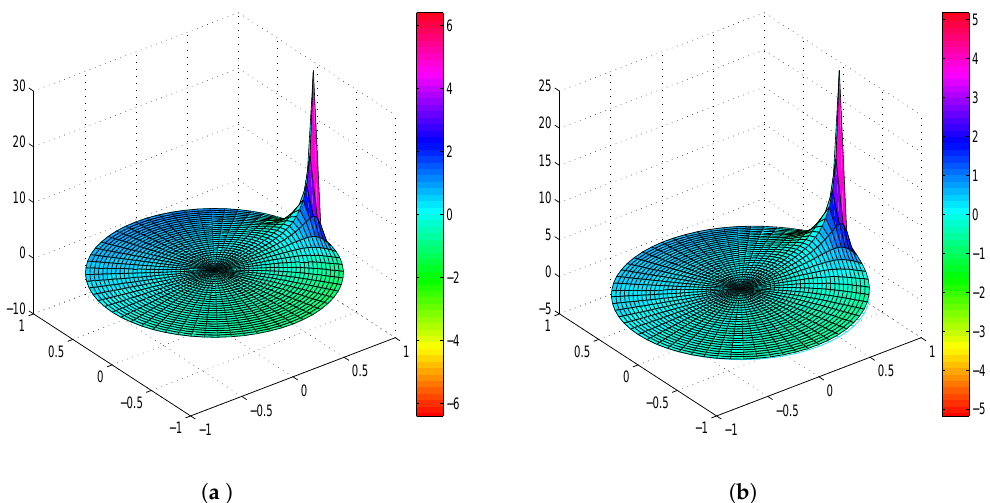
( z ) ; ( b ) The graph of 1